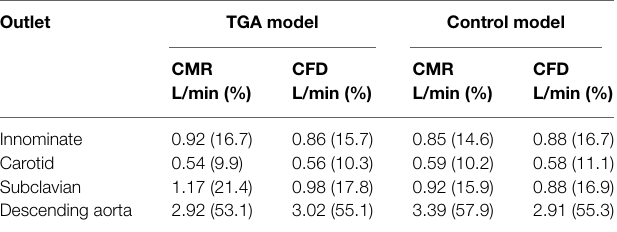
TABLE 2 | Flow distribution in L/min and as % flow split (in brackets) at all outlets of the model, comparing quantification from 2D PCMR and CFD results